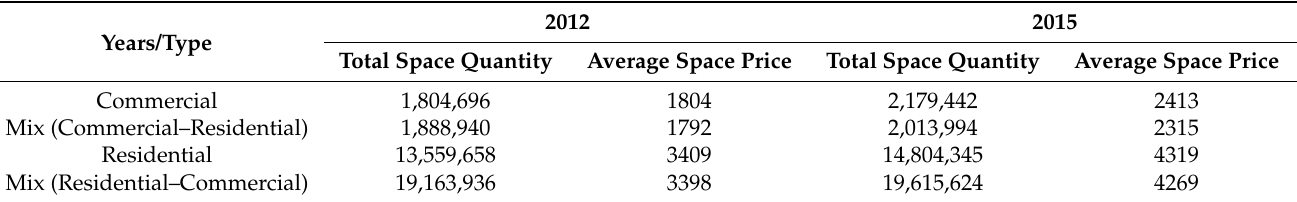
Table 2. Total space quantity ( m  ) and average space price (Yuan/m 2 ).